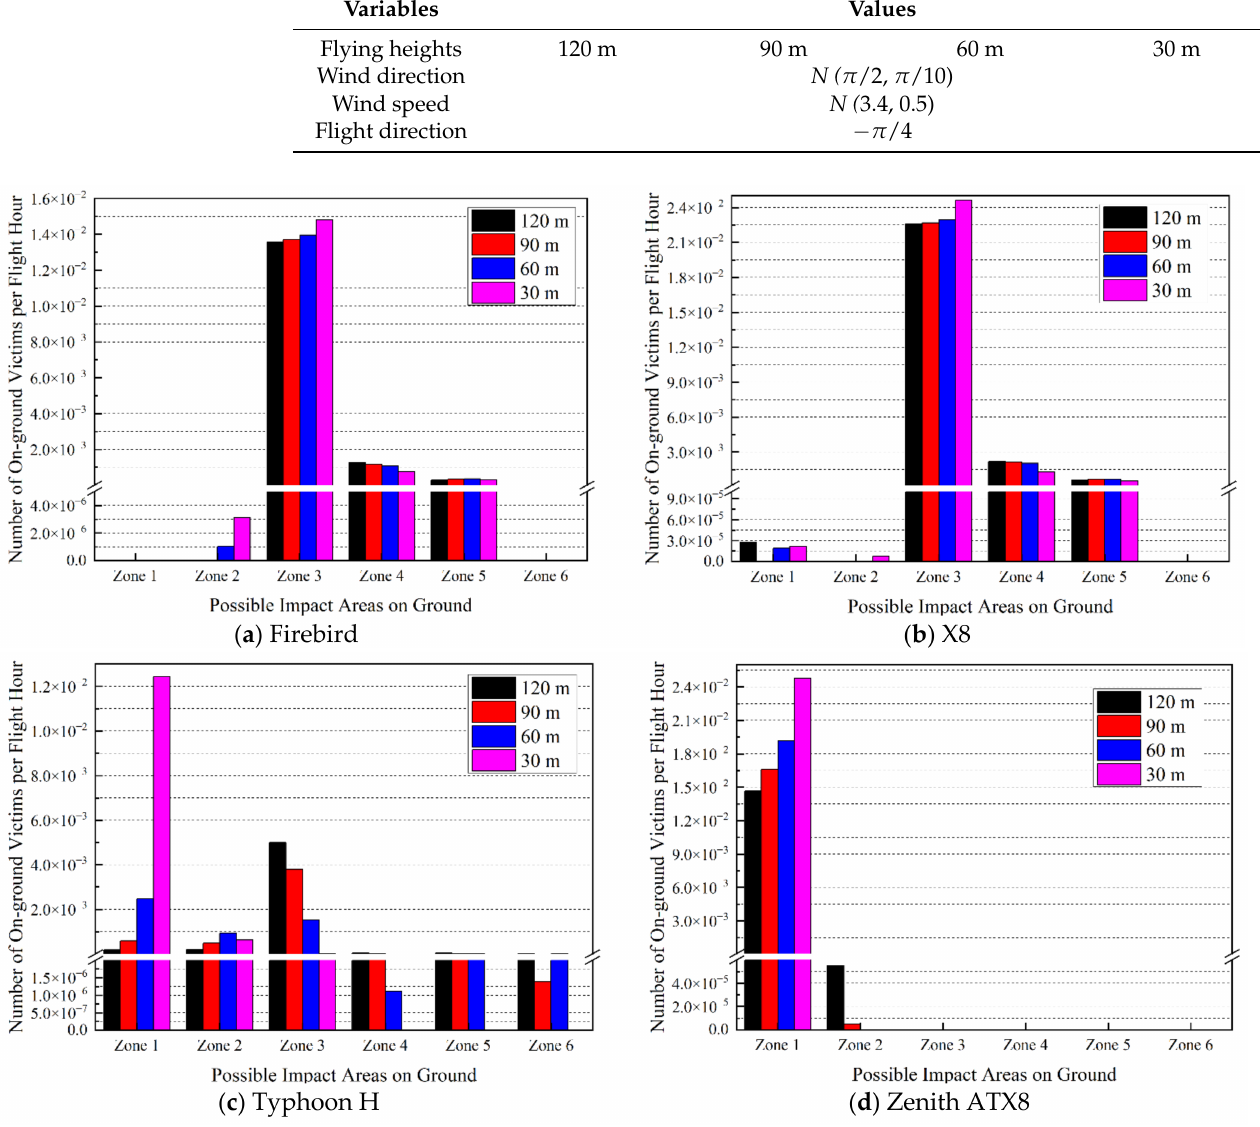
Figure 13. Ground fatalities with different flying